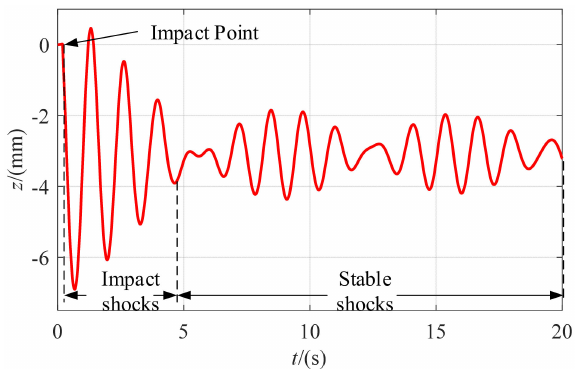
Figure 11. z -axis displacement of the moving platform by impact